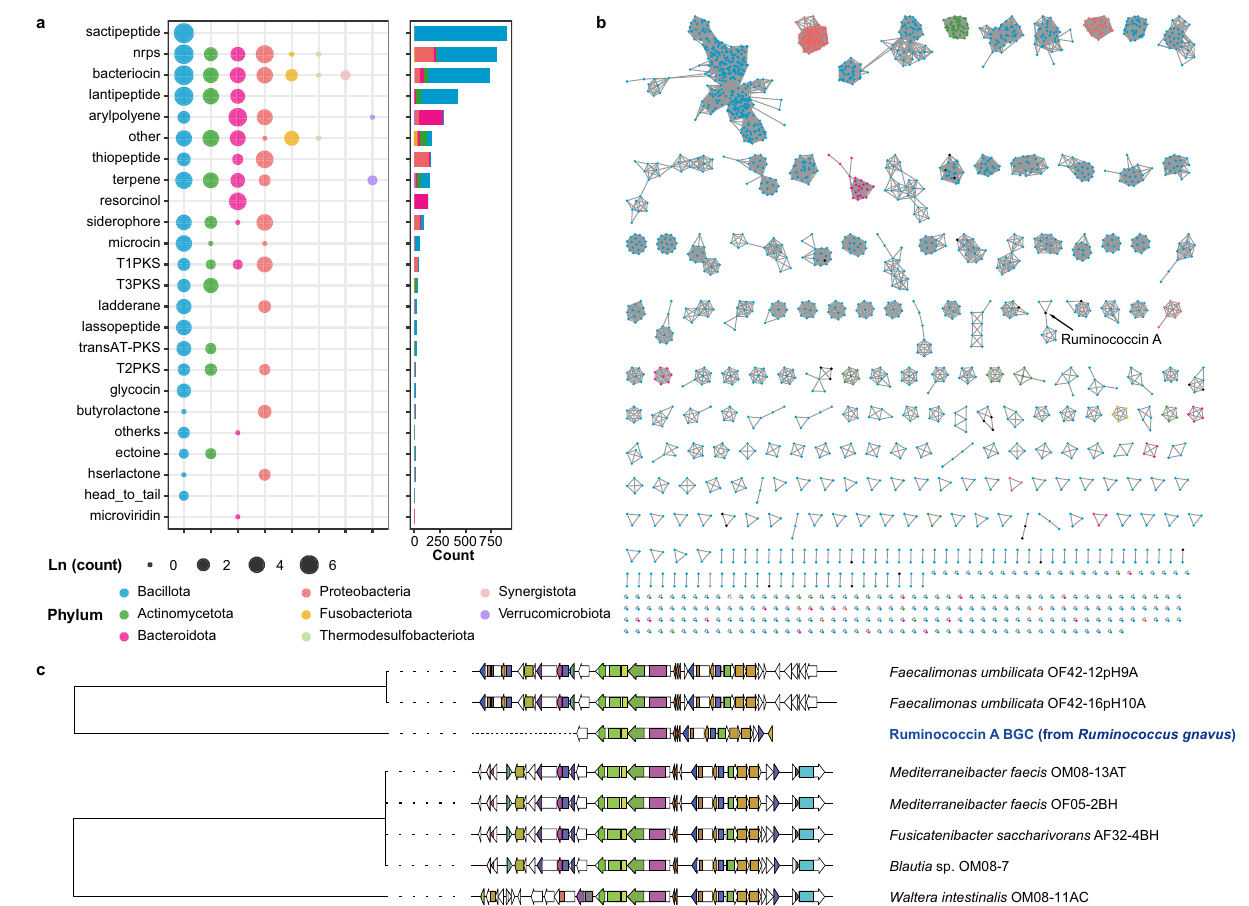
Fig. 3 | Abundant SMBGsinCGR2. a The distribution of SMGBsin different phyla. The sizeof the dot indicates the number ofSMBGs. b Sequencesimilarity network of RiPPs. Nodes represent sequences of BGC domains and are colored by the